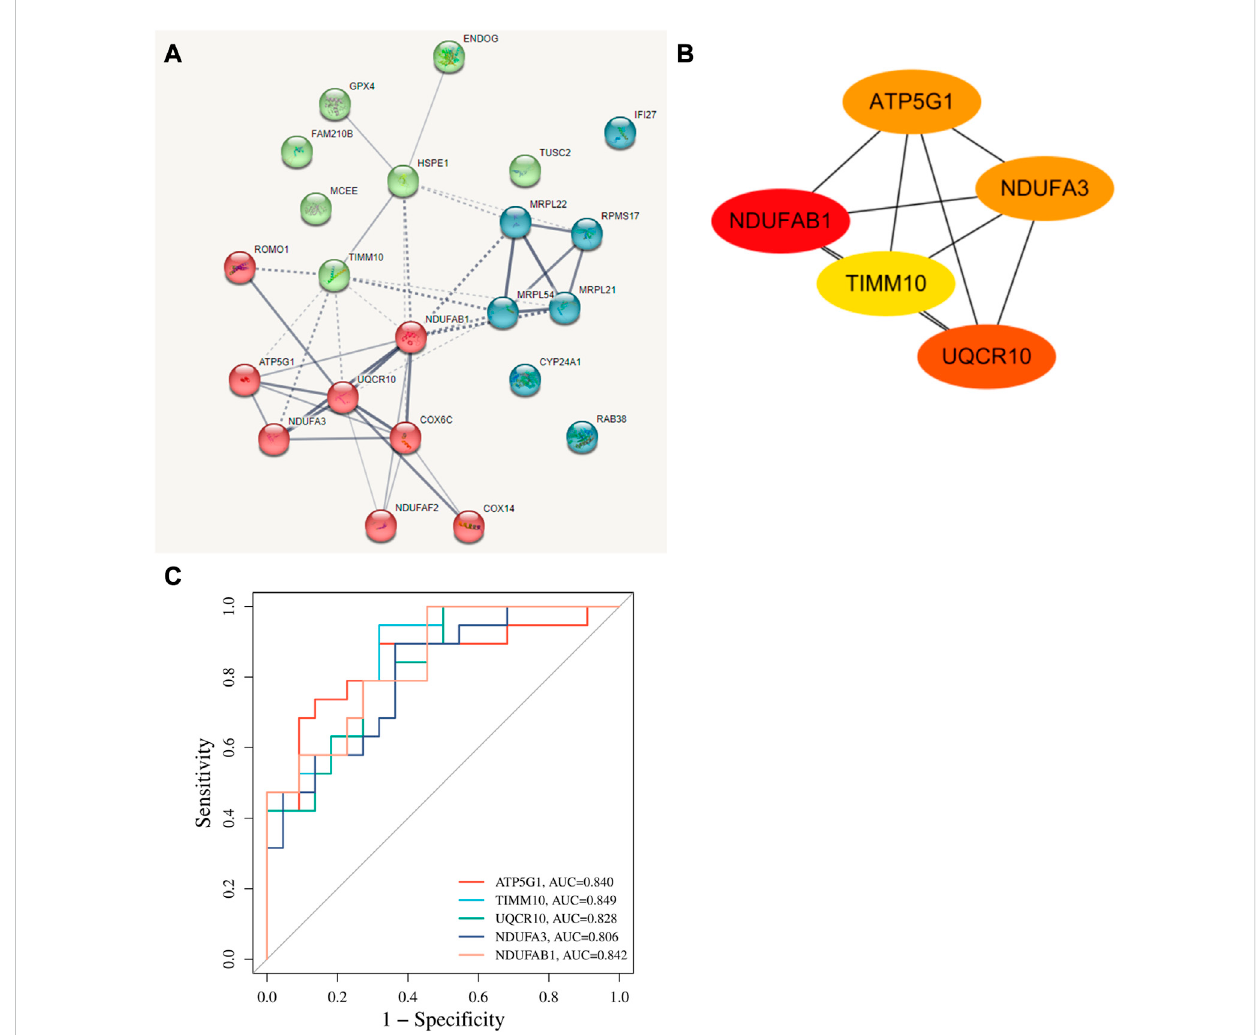
FIGURE 5 Identi fi cation of hub genes. (A) PPI network predicting highly potential interactions with 22 T2-low-Mito DEGs based on SRTING database; (B) Identi fi cation of hub genes from the PPI network with Cytoscape plug-in MCODE; (C) ROC curve of hub genes in dataset GSE4302.